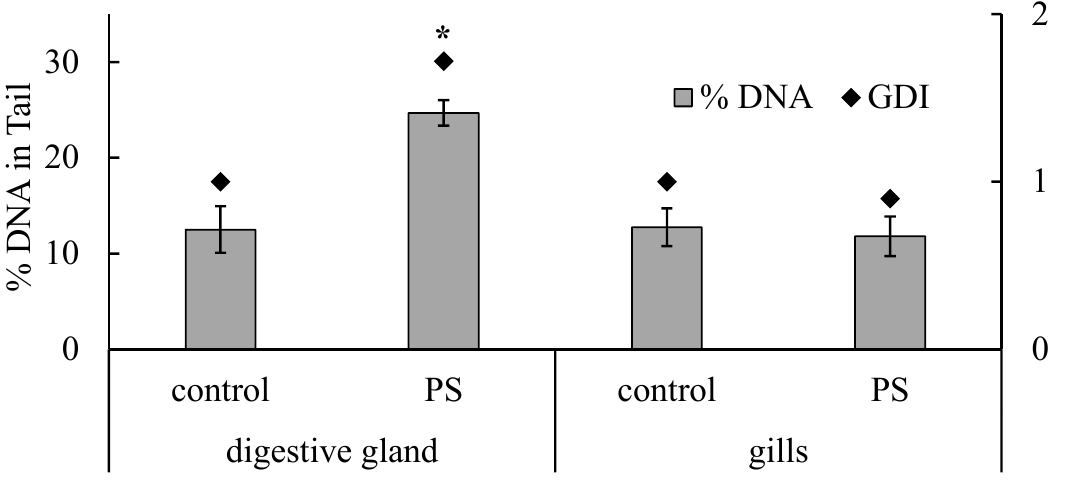
Figure 1. Assessment of DNA damage in gill and digestive gland cells from control and experimental groups (n = 12; n = 600). * Difference from the control is significant ( p < 0.05).